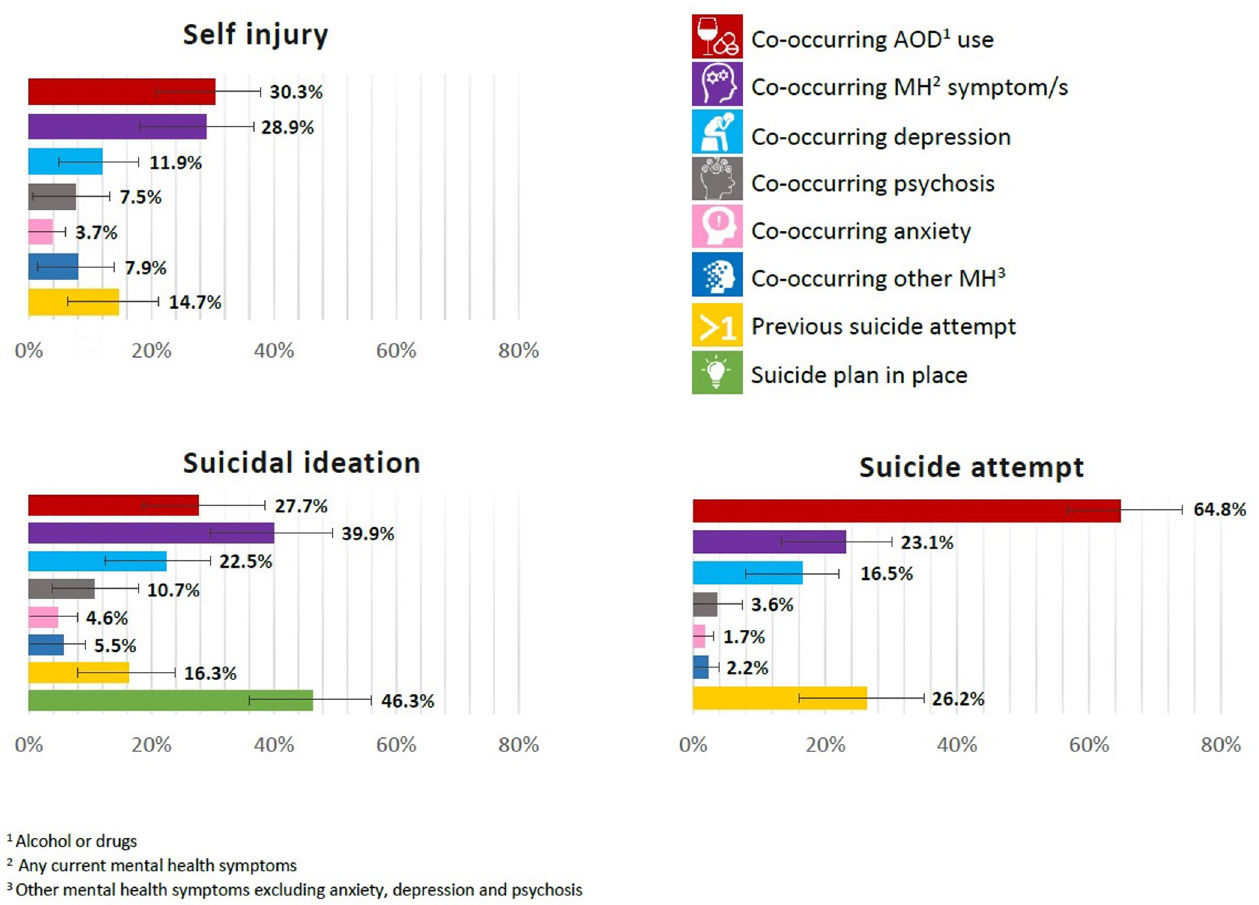
Fig 3. Self-harm types by current mental health and alcohol and other drug comorbidity and historical suicide attempts in 2016/2017 financial year. Error bars represent the binomial proportion confidence interval based on Clopper-Pearson/exact interval.